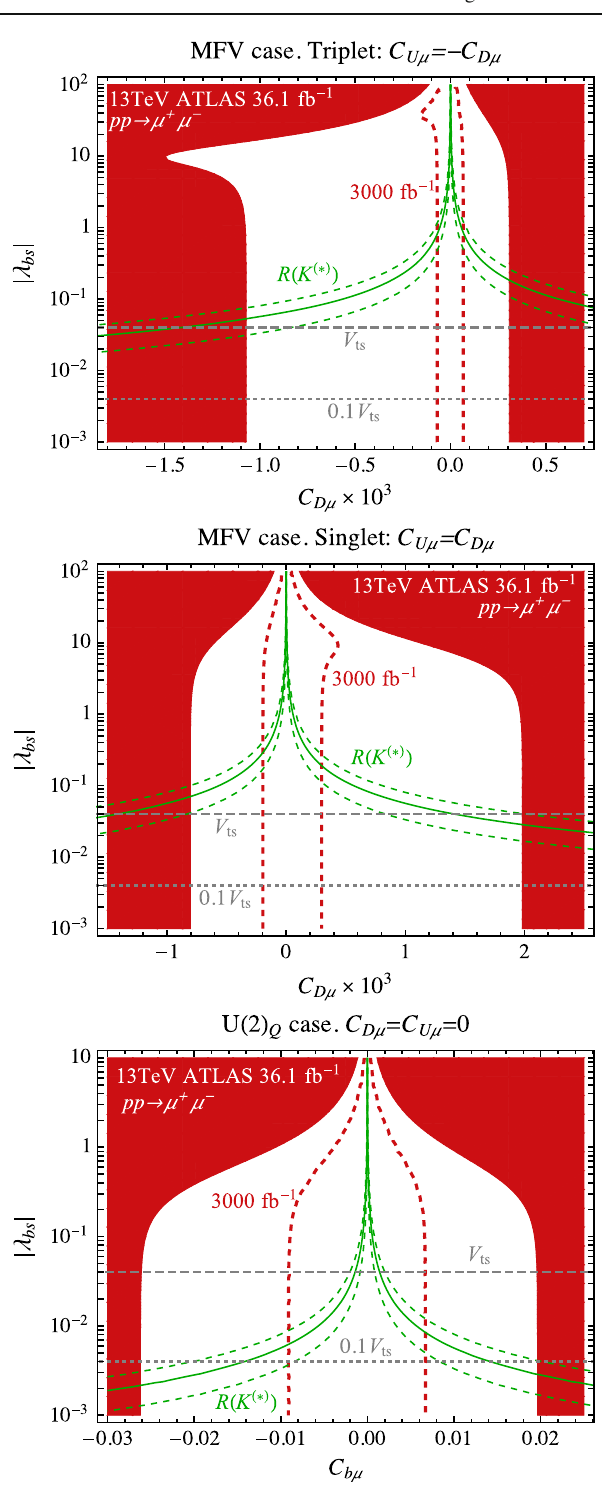
Fig. 4 We show the present ( solid red ) and projected ( dashed red ) 95% CL limit from pp → μ + μ − in the C q μ – | λ bs | plane. The solid ( dashed ) green line corresponds to the best fit (2 σ interval) from the fit of the flavor anomalies in Eq.